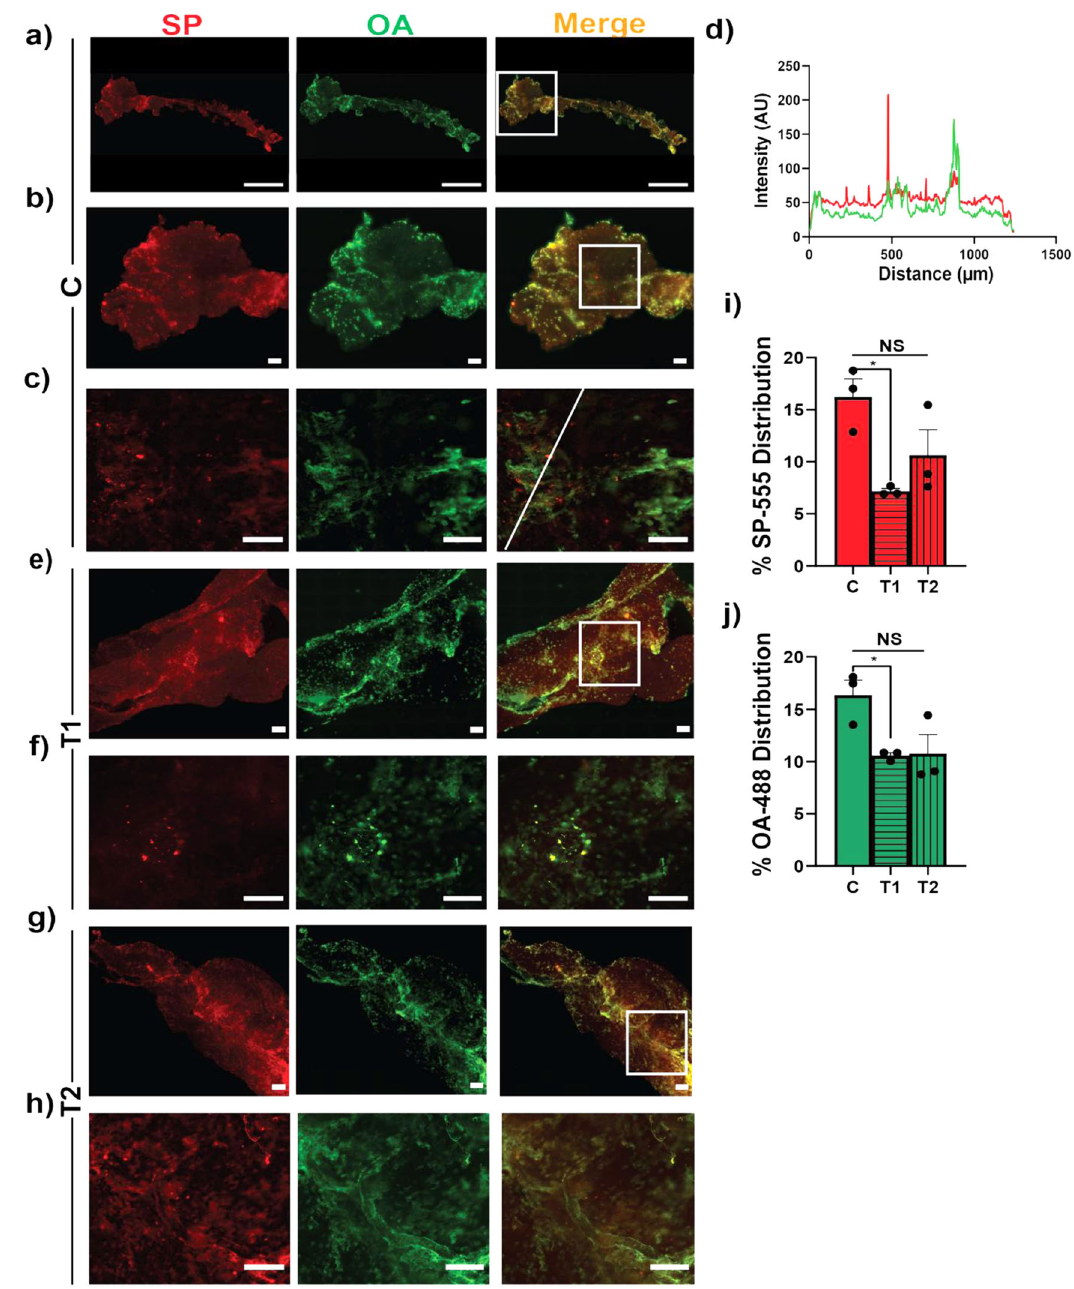
Fig. 5 SP-555 is taken up by the isolated CP. a – c Representative images of SP-555, OA-488, and merged images for the isolated CP after incubation for 60 min. Lower panels are the magni fi ed images of the boxed area in the upper panels. d Intensity plot of the line in c . It crosses one of the many red dots (SP-555) showing local high intensity. e , f Representative images of SP-555, OA-488 and merged images for the isolated CP after incubation with anti- ACE2 antibody. g , h Anti-SP antibody with the SP-555 and OA-488 for 60 min. Lower panels are the magni fi ed images of the boxed areas. i , j Quanti fi cation of the SP-555 and OA-488 signal intensities for the whole areas. Scale bars: a (1 mm); b – h (100 μ m). N = 3. CP was pre-incubated with T1 and T2 for 15 min and during incubation with the tracers for 60 min. Images enhanced for better presentation of details. Analysis was reformed without